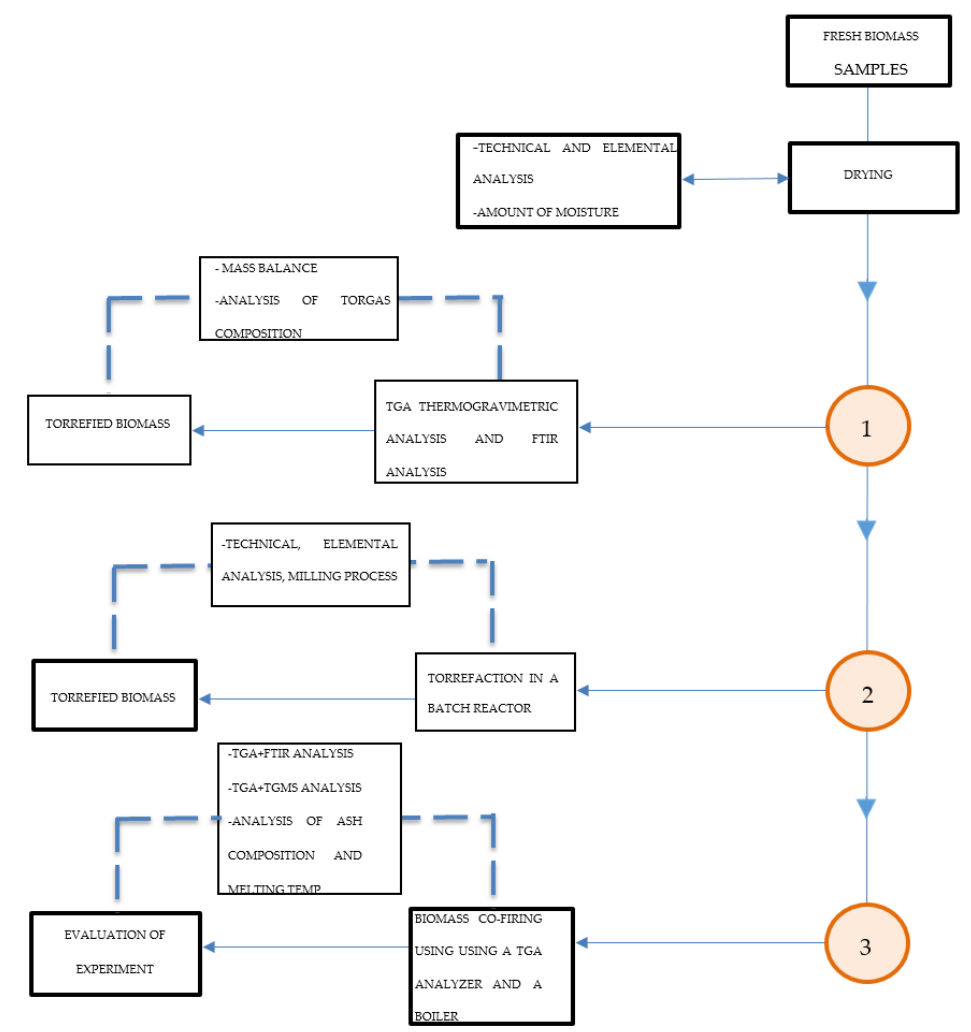
Figure 14. Scheme of the Jerusalem artichoke torrefaction process analytical method order: TGA, DTA, TG-FTiR, TG-MS torrefaction process, and biomass combustion plus SEM-EDS ash analysis.